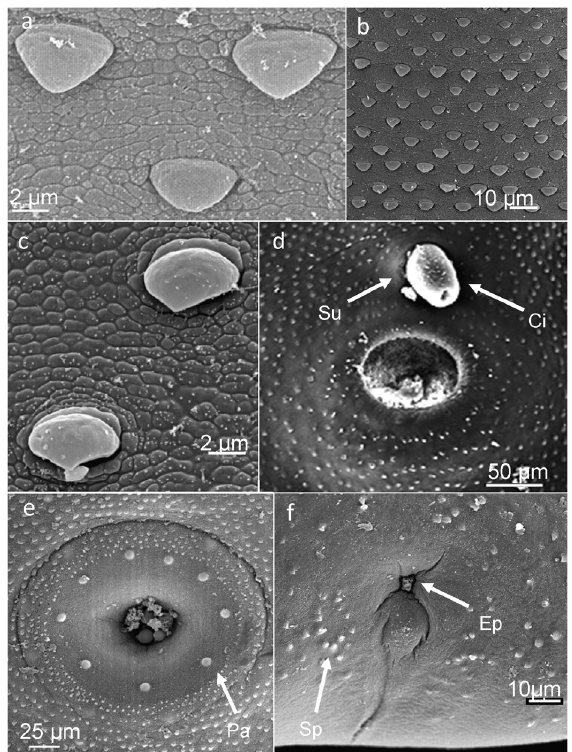
Figure 2. Scanning electron micrographs of Choledocystus incurvatum ( a ) tegumental spination of anterior ventral body region, ( b ) arrangement of spines on anterior region of ventral sucker, ( c ) tegumental spination of posterior ventral body region, ( d ) genital pore showing sucker surrounding its opening and everted cirrus, ( e ) detail of the ventral sucker with spines and papillae, ( f ) posterior end of body showing spines and excretory